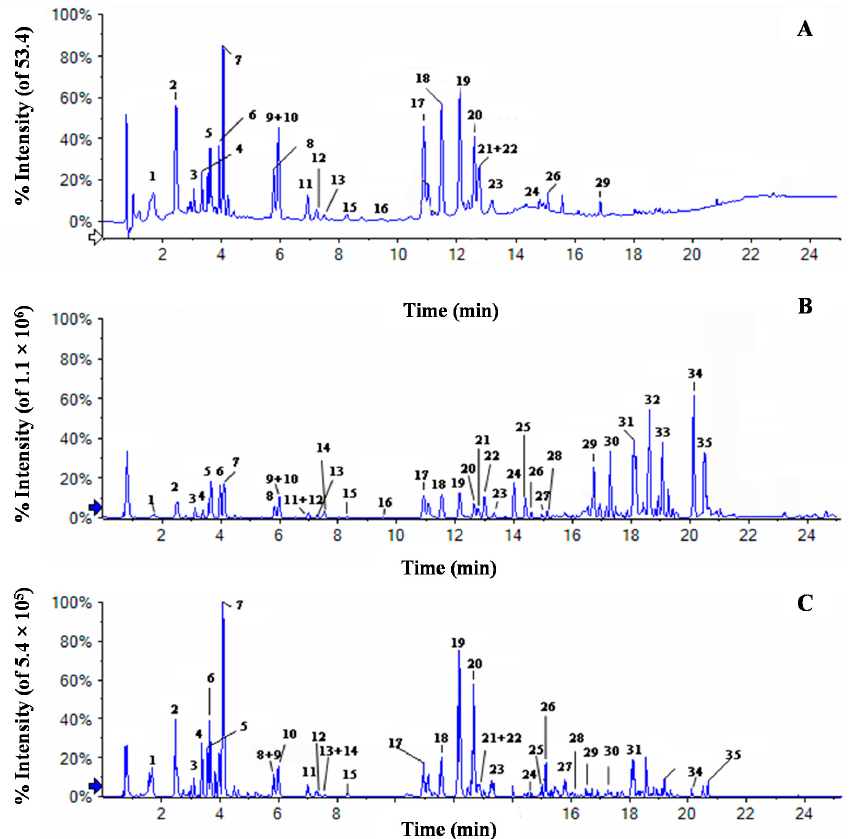
Figure 4. Chromatograms of water extract of H. diffusa : ( A ) DAD chromatogram detected at 254 nm; ( B ) total ion chromatogram in positive ion mode; and ( C ) total ion chromatogram in negative ion mode). White arrow means DAD chromatogram ( A ) and the blue arrows means MS chromatogram in positive and negative ion mode ( B , C ).